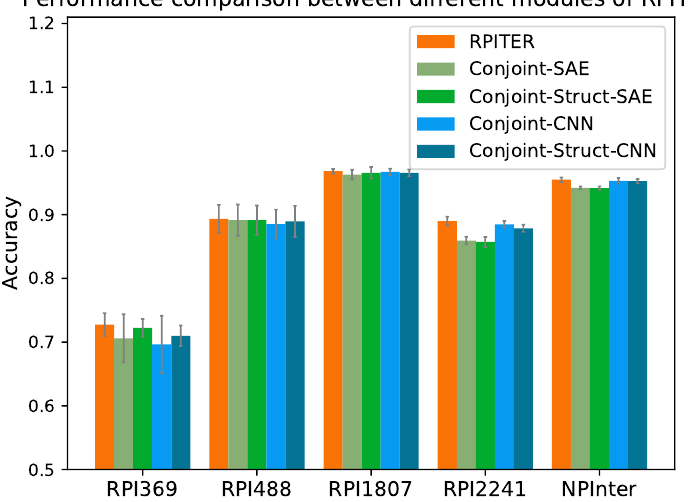
Figure 4. Performance comparison among different prediction modules of